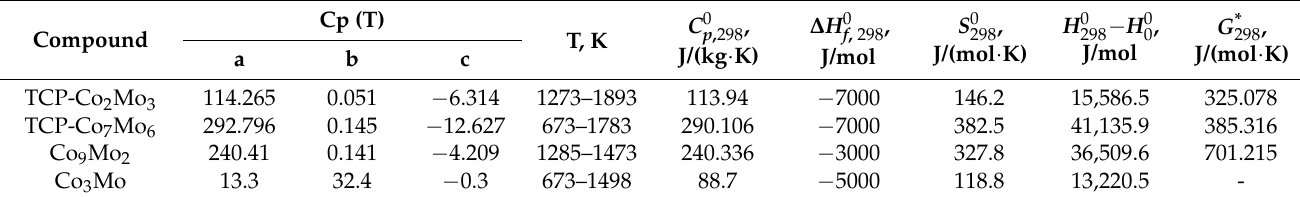
Table 2. Thermodynamic properties of some substances used in the calculation.